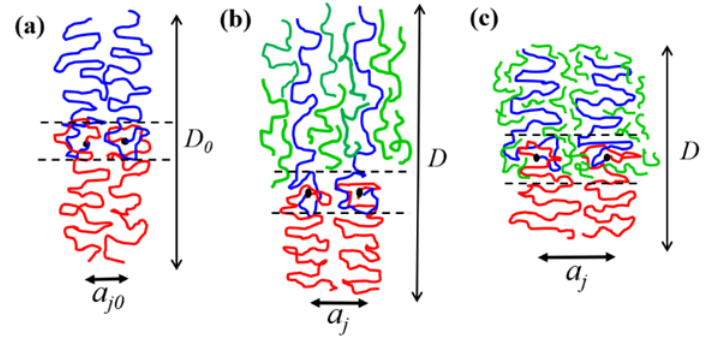
Figure 7. Schematic illustration of the structure of the interface in EO4VP and EO4VP/h-P4VP blends: ( a ) neat EO4VP in which the interface composes EO and 4VP segments from the constituent blocks; ( b ) EO4VP/h-P4VP blend with higher M h-P4VP , in which the h-P4VP chains were segregated out of the interfacial region completely; ( c ) EO4VP/h-P4VP blend with low M h-P4VP , in which a fraction of h-P4VP chains or their segments entered the interfacial region. The polymer chains in blue, red and green color represent the P4VP block, PEO block and h-P4VP,